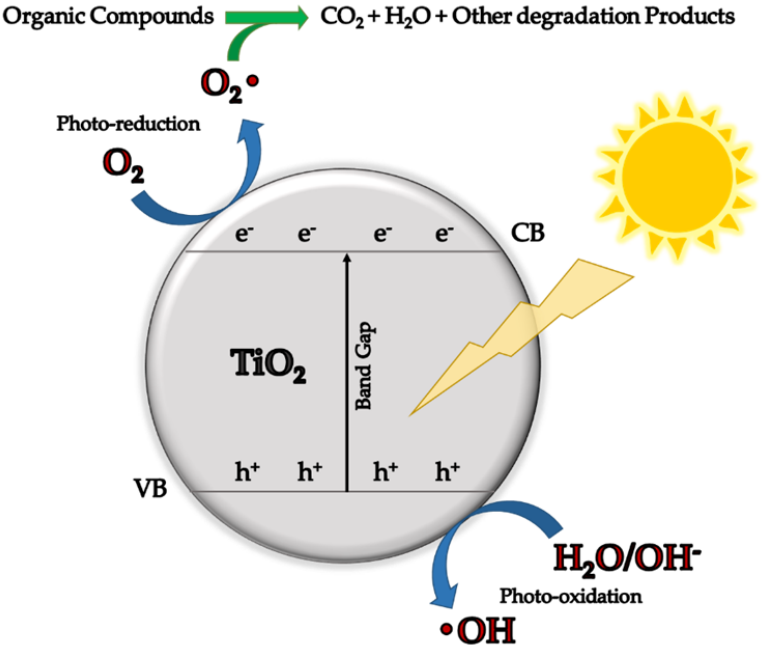
Figure 5. Mechanism of photodegradation of organic compounds by TiO 2 .